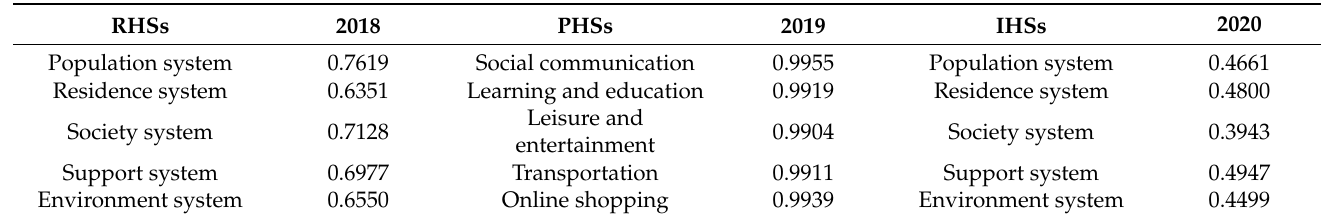
Table 4. Detection results of difference factors at different levels of the high-quality coordinated development of “three states” human